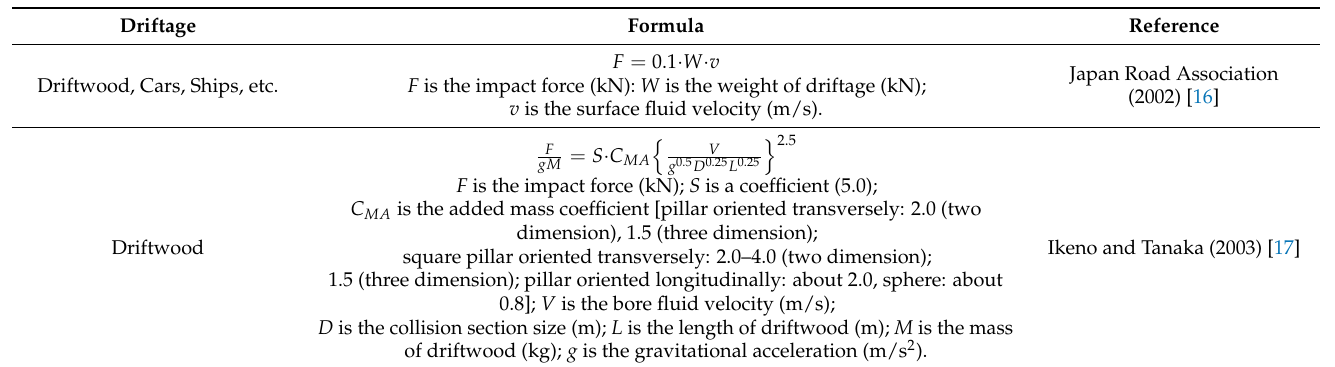
Table 3. Impact force formula (no.